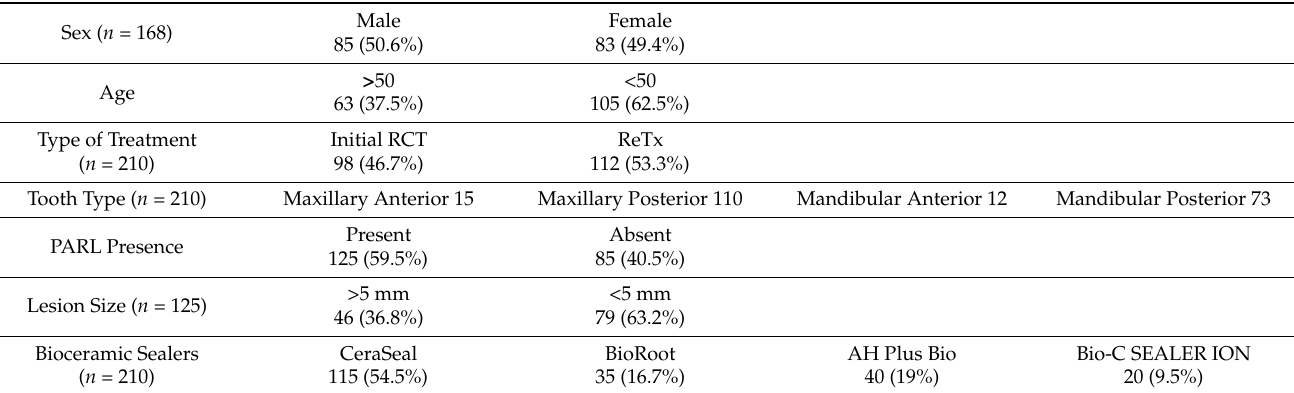
Table 1. Population demographics and type of treatment. (PARL, periapical radiolucency; RCT, root canal treatment; ReTx,